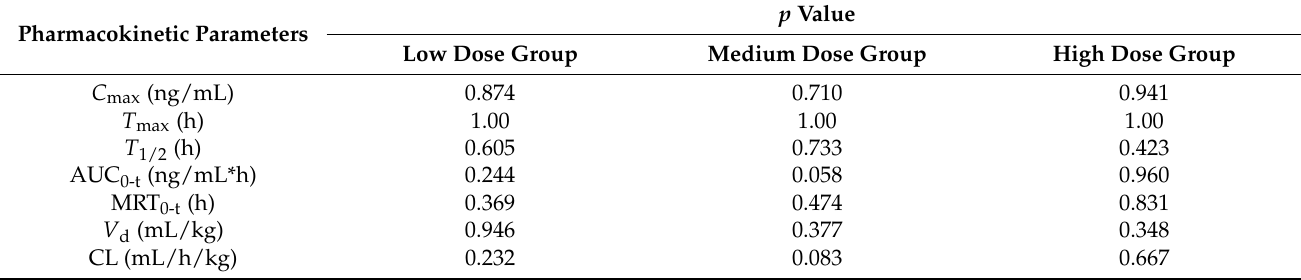
Figure 2. The average blood concentration-time curve of each analyte (( A ): GAMG; ( B ): GA) at 0–48 h after ig low (L), medium (M) and high (H) three dose groups of GAMG ( n = 8). After intragastric administration of GAMG at three doses of 7.5, 15, and 30 mg/kg, C max and AUC 0-t showed dose correlations. As the dose increases, C max and AUC 0-t also increase proportionally (Figures S3 and S4). The PK parameters of GAMG and its metabolite GA in rat plasma of the three dose groups were tested by Dunnett’s t test using SPSS 17.0 software, and the p values obtained were all >0.05 (Tables 6 and 7). The PK parameters of GAMG and GA in the three dose groups were not significantly different by sex. Table 6. The statistical difference of the main PK parameters of GAMG in different dose